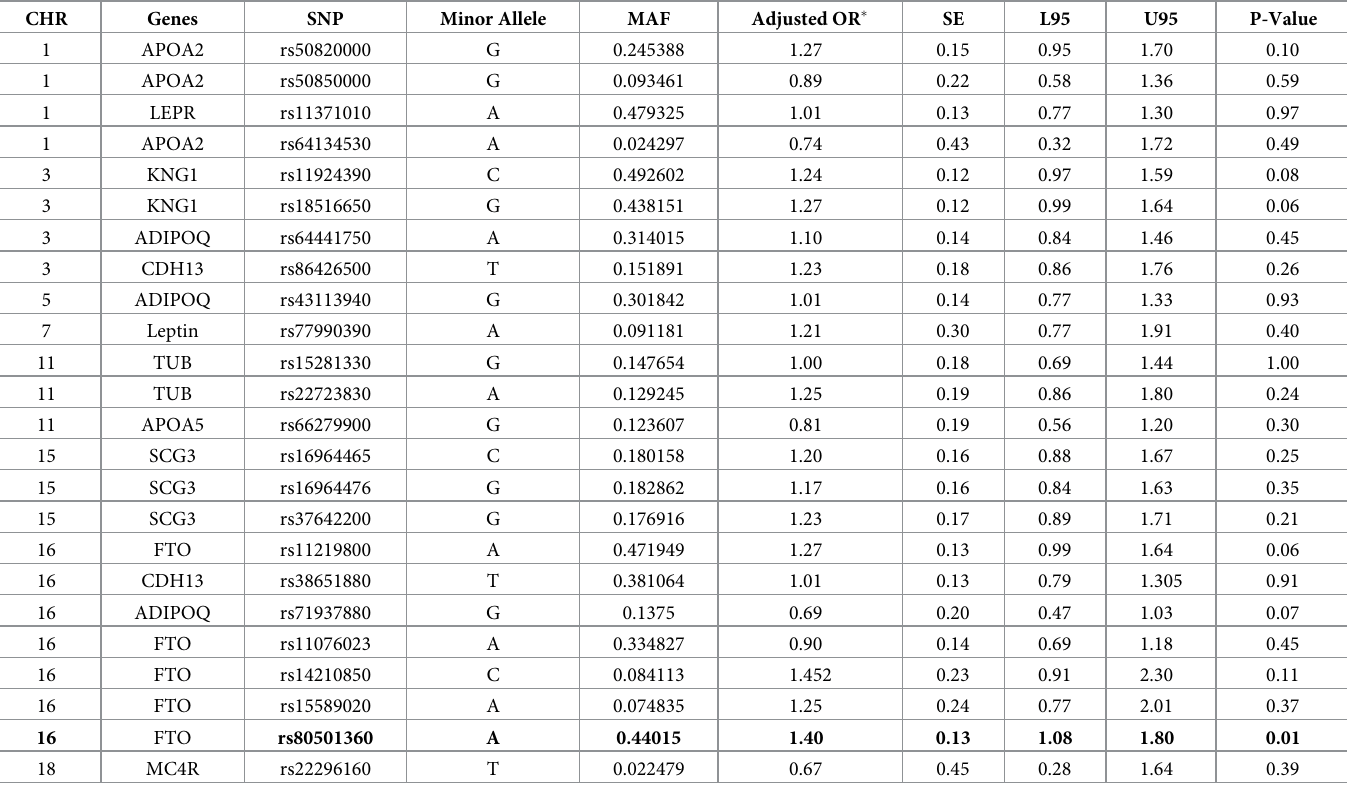
Table 2. Multivariable analysis of BMI groups in African